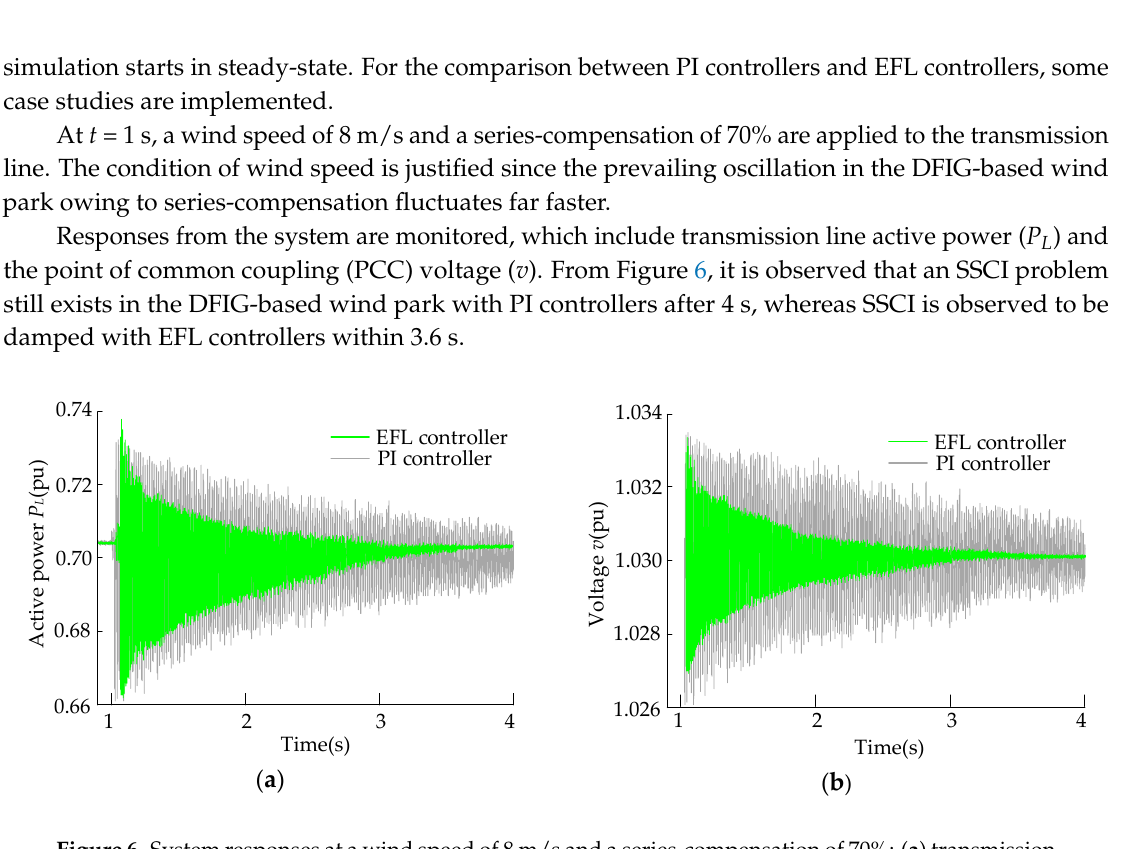
( b ) Figure 8. System responses at a wind speed of 8 m/s and a series-compensation of 40%. ( a ) Transmission line active power; ( b ) PCC voltage. A c t i v e p o w e r P L ( p u ) Time(s) EFL controller PI controller ( b ) Figure 9. System responses at a wind speed of 10 m/s and for a series-compensation of 70%. ( a ) Transmission line active power; ( b ) PCC voltage. 6. Conclusions In order to mitigate sub-synchronous control interaction in the series-compensated DFIG-based wind parks, this paper proposes nonlinear controllers based on an exact feedback linearization (EFL)